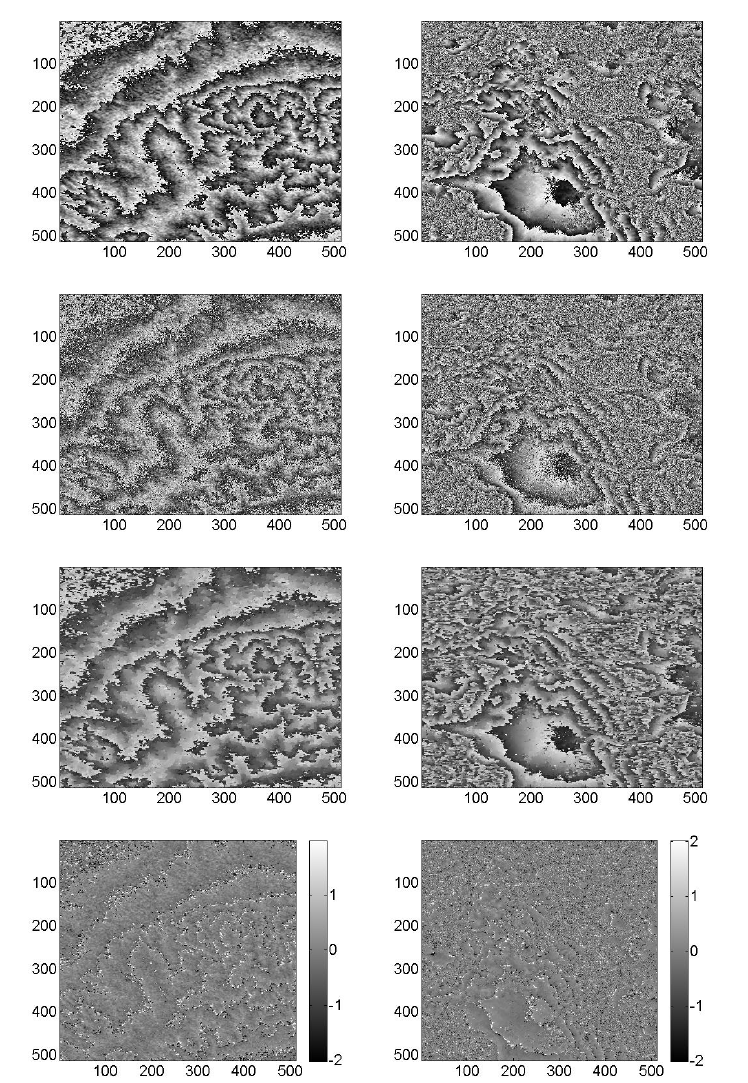
Figure 3: Real interferograms filtering results. The first column using Radarsat-2 interferogram and the second column using ERS satellite and from top to bottom: the original interferogram produced from ASTER DEM, the observed noisy interferogram, filtered with the proposed approach and the filtering error with respect to column